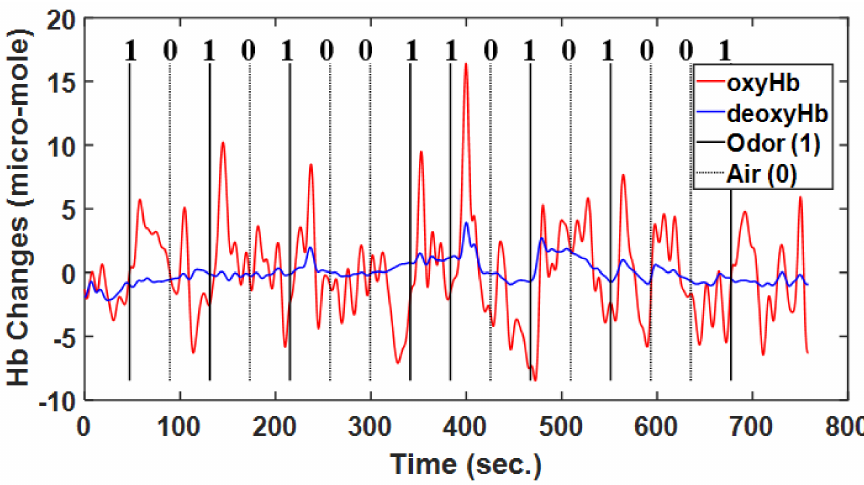
Figure 5. Typical example of raw hemodynamic response function including oxyHb and deoxyHb data, with air and odor as the stimuli, in accordance with the experimental paradigm.